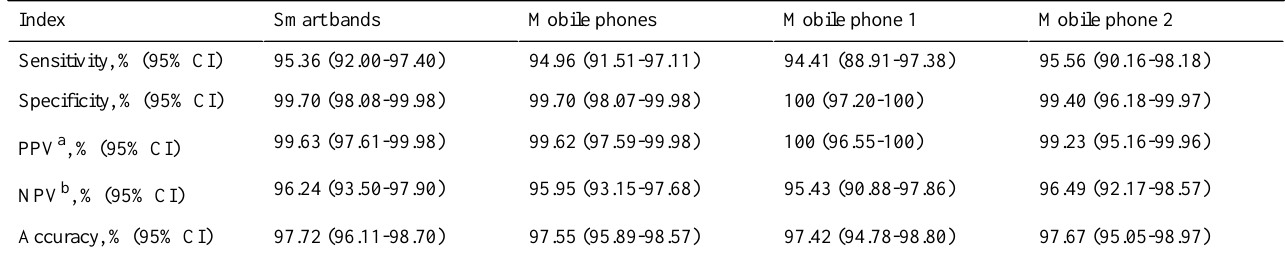
Table 2. Detailed diagnostic performance of the photoplethysmography technology for atrial fibrillation screening in different smart devices.